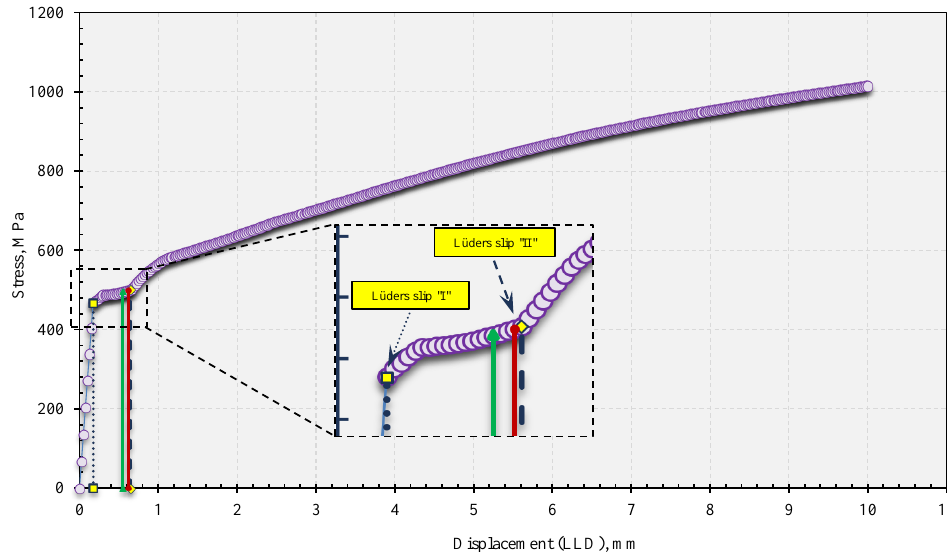
Figure 9. The load-displacement curve for a ring with the ratio R / B = 5 and a crack depth of a / W = 0.45. The figure shows the position of the points where we met specific criteria for determining the limit load on the inner and outer side and for the case of taking the Lüders slip into account.